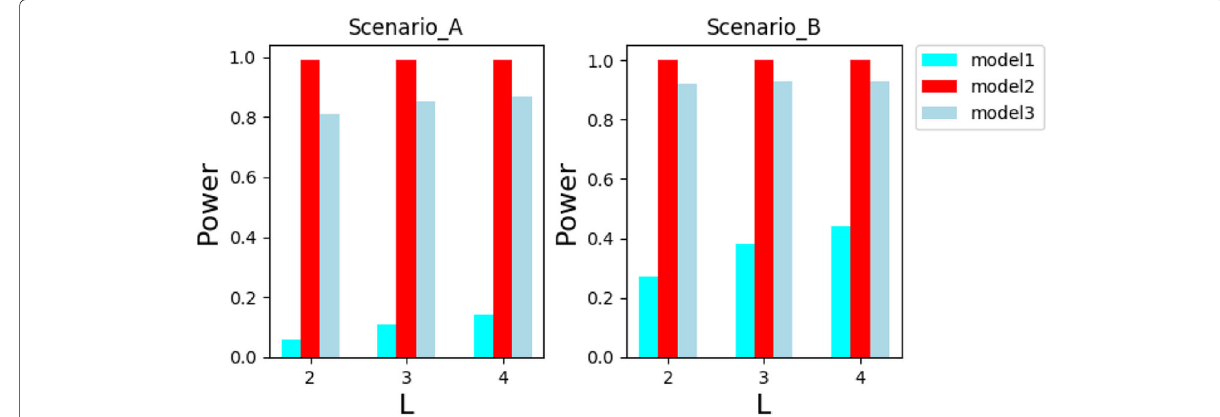
Fig. 2 020501( MAF = 0.2, λ = 0.5, r 2 = 1)